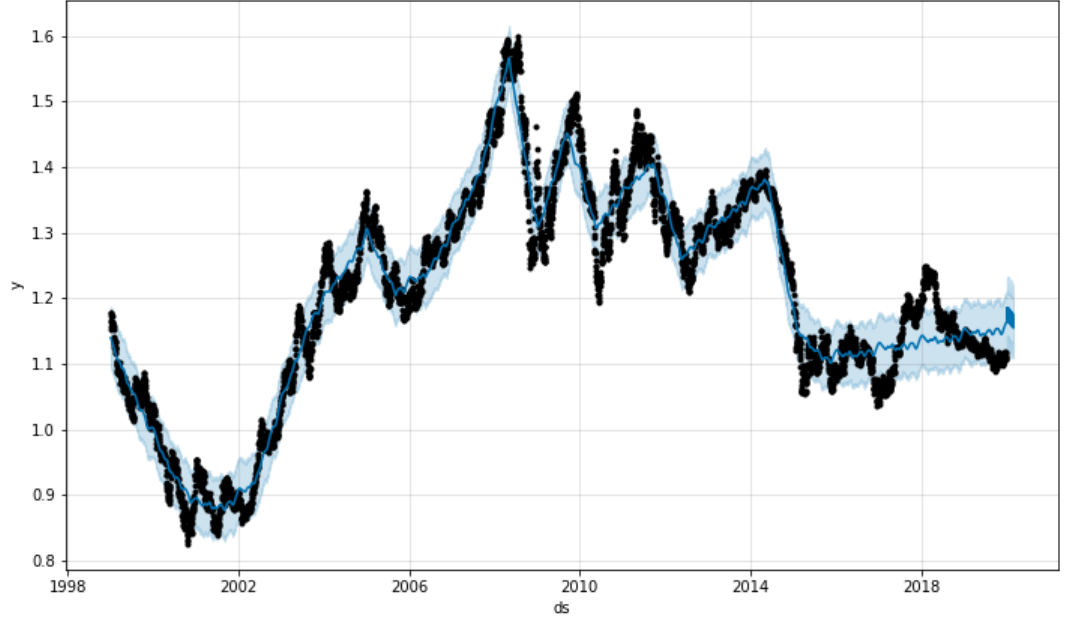
Figure 1. Graph showing the data [45] and the model obtained using the Prophet